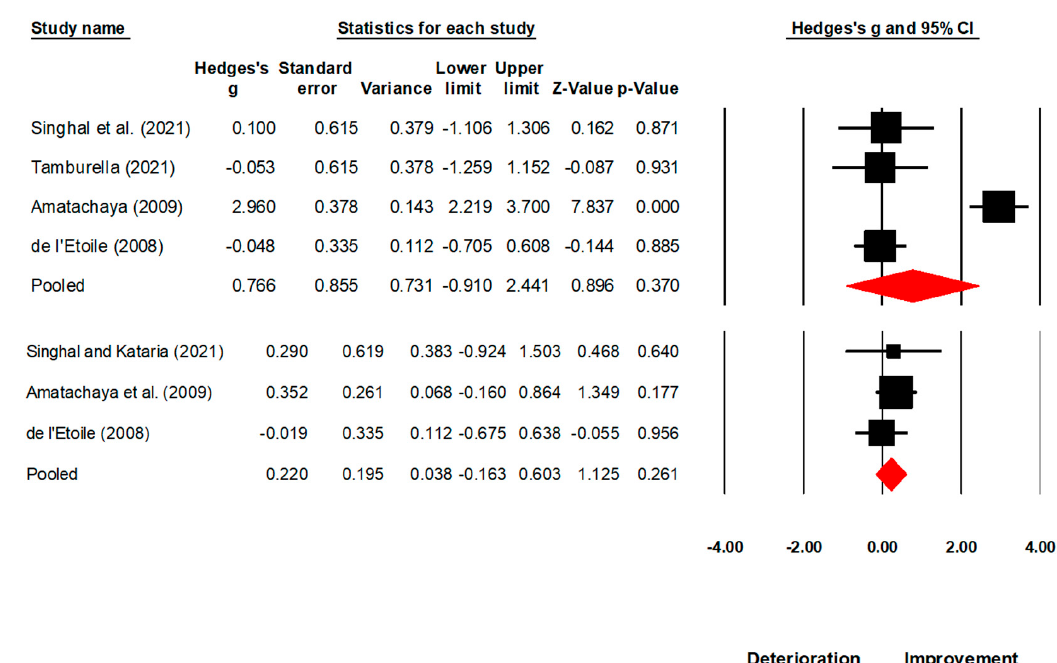
Figure 6. A forest plot depicts the impact of MT on overall spatiotemporal gait outcomes in individuals with SCI. It includes individual weighted e ff ect size Hedge’s g represented as black circles, and the whiskers represent the 95% con fi dence intervals. The pooled weighted e ff ect size and 95% CI are presented at the bo tt om with a red diamond. A positive overall e ff ect size in this analysis implies an enhancement in spatiotemporal outcomes of gait with MT, while a negative overall e ff ect indicates a decline in spatiotemporal outcomes of gait with MT. Refs [60,61,64,66] mentioned.